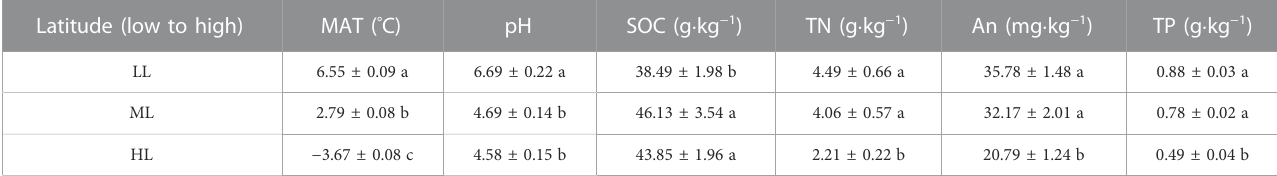
TABLE 2 Chemical properties of forest soil at three different latitudes. Latitude (low to high)